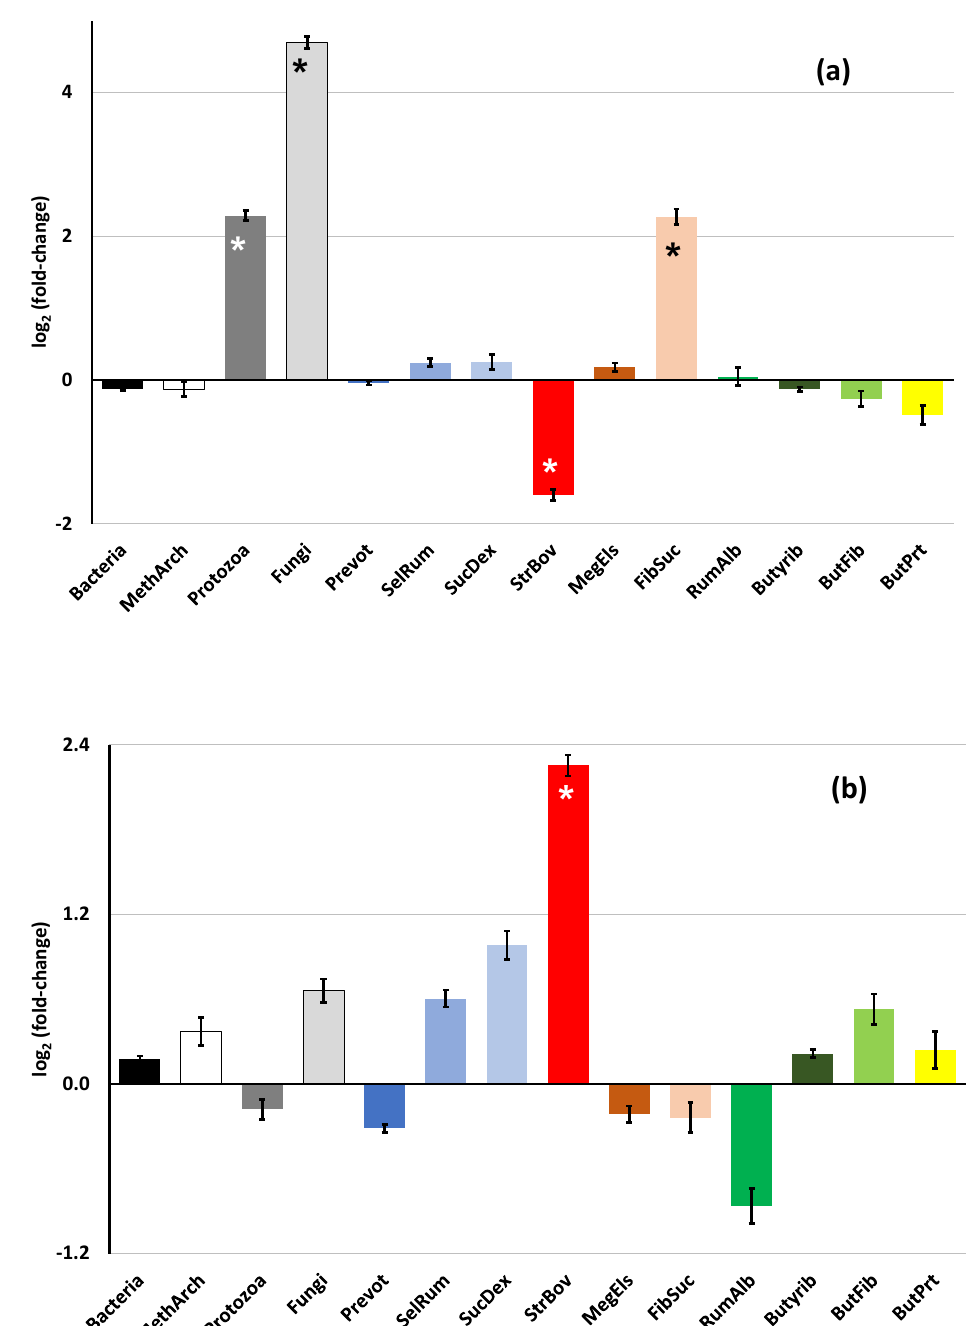
Figure 1. Effects of diet ( a ) and pH in the medium ( b ) on rumen microbial community profile in continuous cultures. In Figure 1a, effects are shown as fold-change (in log 2 units) of the high forage diet over the high concentrate diet. In Figure 1b, effects are shown as fold-change (in log 2 units) of the higher pH (6.8) over the lower pH (6.4) in the incubation medium. The symbol “*” in the bar represents a significant ( p < 0.001) difference; in bars with no “*” the difference between treatments did not reach statistical significance ( p > 0.05). The abbreviations used for the microbial groups are MethArch = Methanogen Archaea; Prevot = Prevotella spp.; SelRum = Selenomonas ruminantium ; SucDex = Succinivibrio dextrinosolvens ; StrBov = Streptococcus bovis ; MegEls = Megasphaera elsdenii ; FibSuc = Fibrobacter succinogenes ; RumAlb = Ruminococcus albus ; Butyrib = Butyrivibrio group; ButFib = B. fibrisolvens ; ButPrt = B. proteoclasticus .